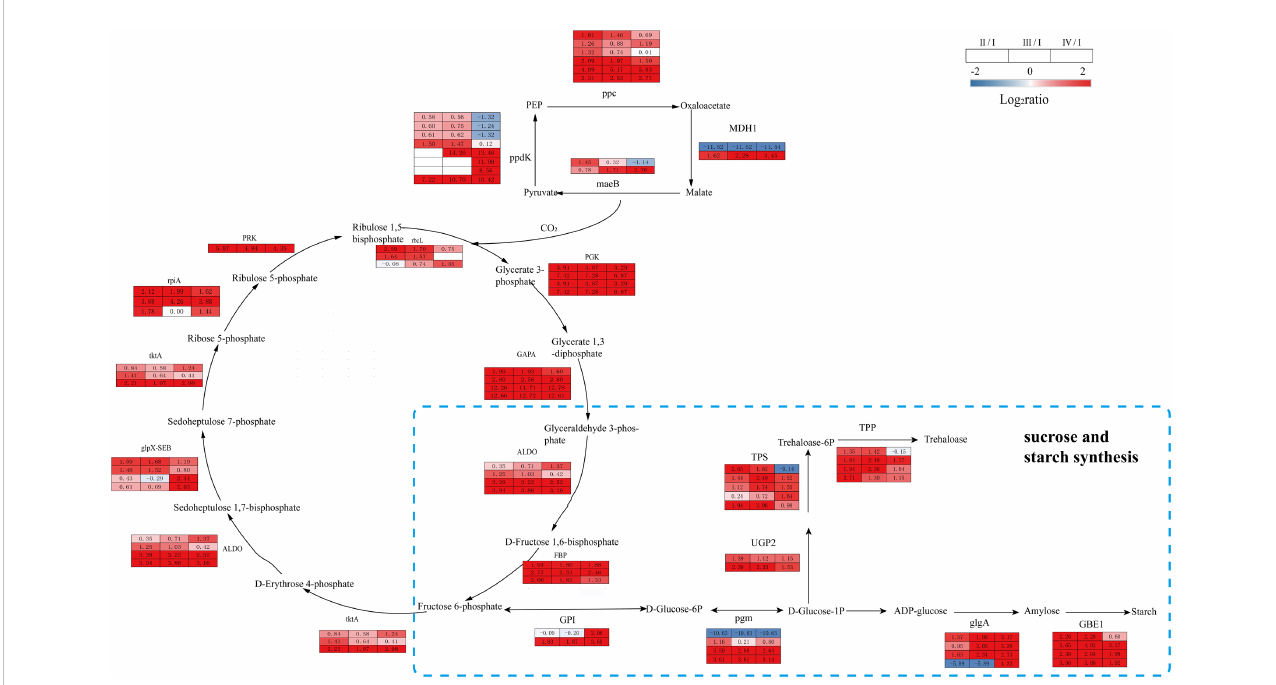
FIGURE 7 The transcriptomic changes with carbon fi xation metabolism and sucrose and starch synthesis in the tetraspore formation of G. lemaneiformis between different phases. Red and blue gradients indicate the upregulation and downregulation of unigenes with the adjusted p value <0.001 and |log2ratio| > 1, separately, while white represent no signi fi cant